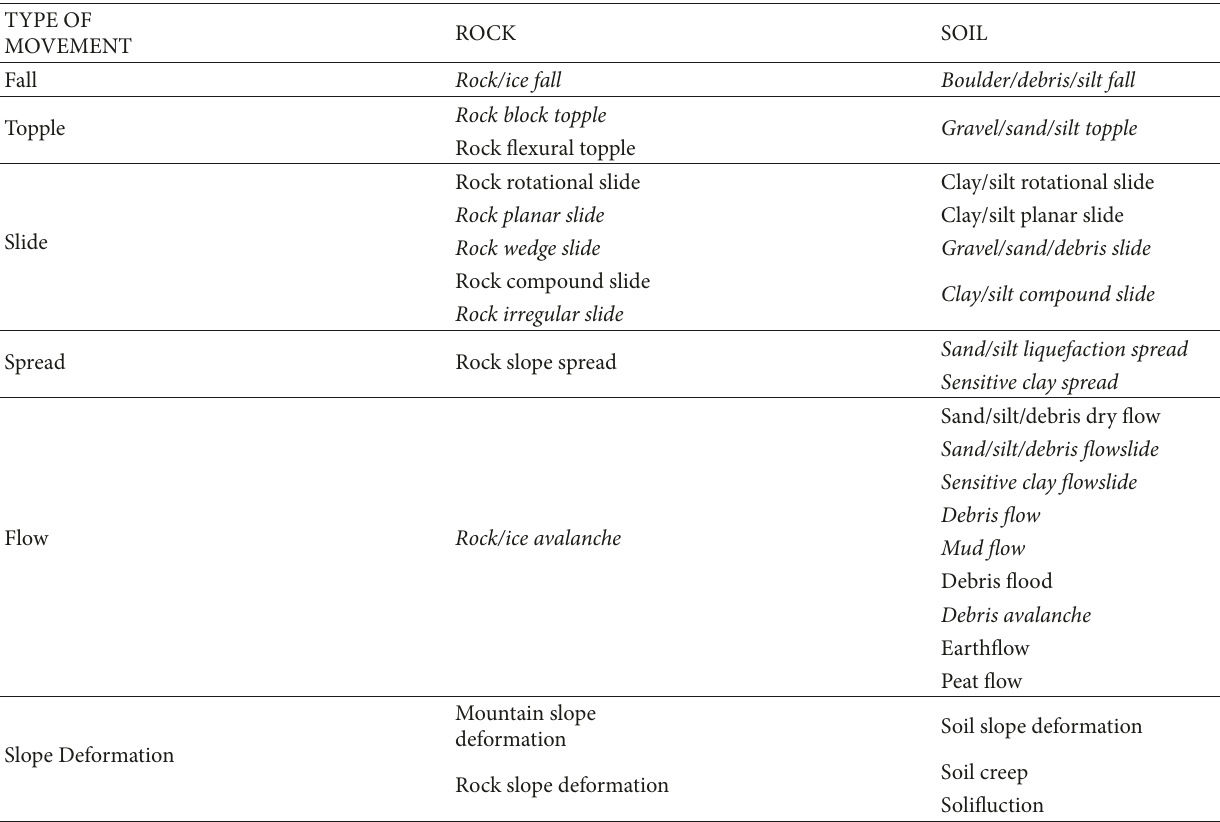
Table 1: Nomenclature of the newly proposed landslide classification version according to [4] based on the Varnes classification system. Words divided by / (slash symbol) have to be used alternatively. In italic movement types that usually reach extremely rapid velocities as defined by [2], while for the others, the velocity varies between extremely slow to very rapid (for details, refer to